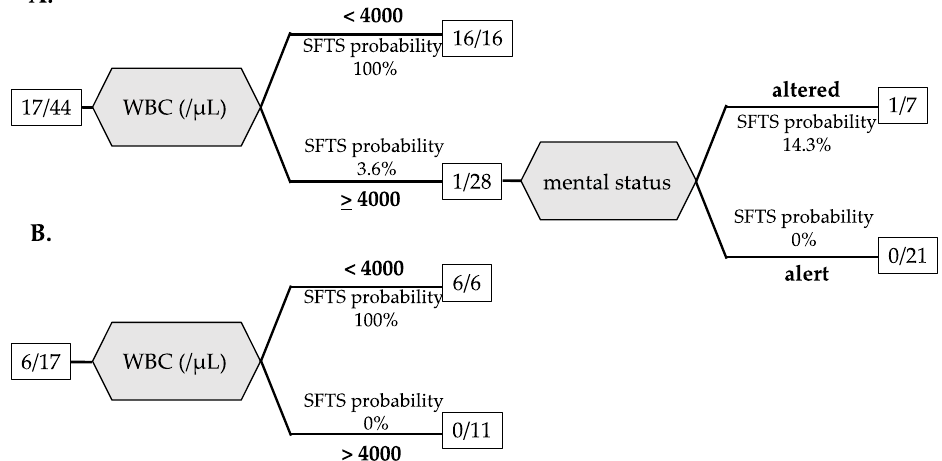
Figure 1. Decision tree classification of SFTS and JSF based on laboratory data and physical examination for the training cohort ( A ) and the validation cohort ( B ). The number in the square is the number of SFTS patients/total patients.